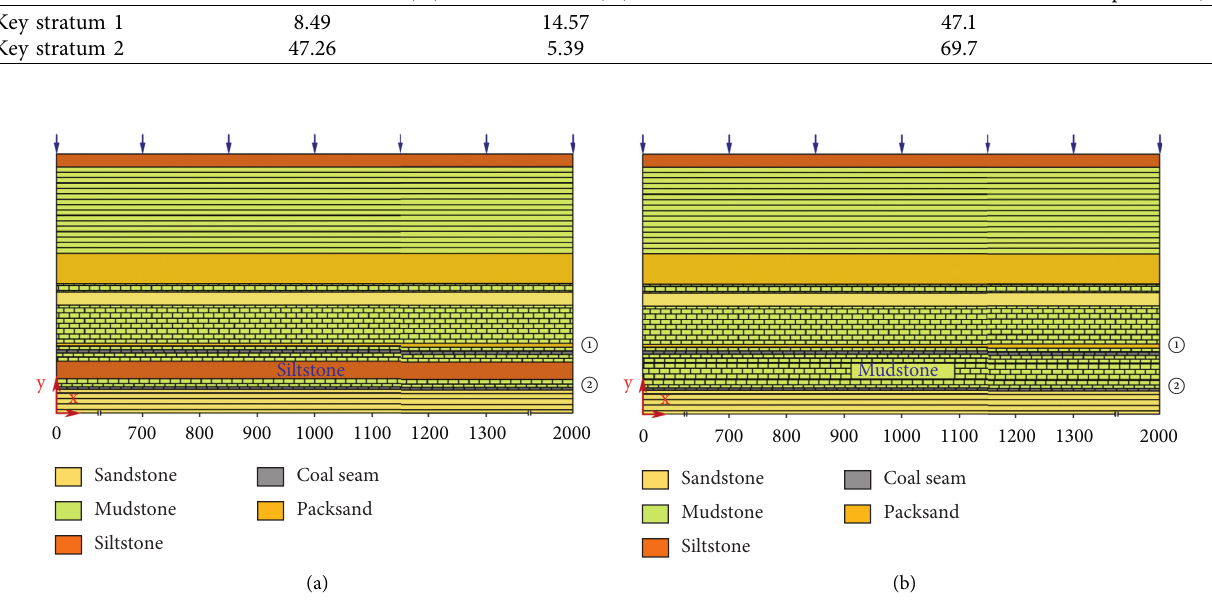
Table 2: Influence distance of advanced abutment pressure under the influence of key strata 1 and 2. No.